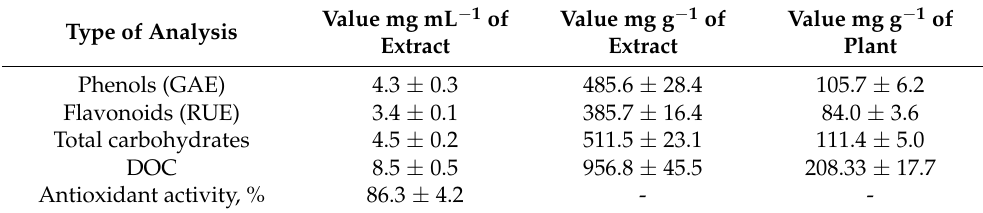
Table 1. Total phenol, flavonoids and carbohydrates contents in the plant extracts and plant biomass of Solidago canadensis